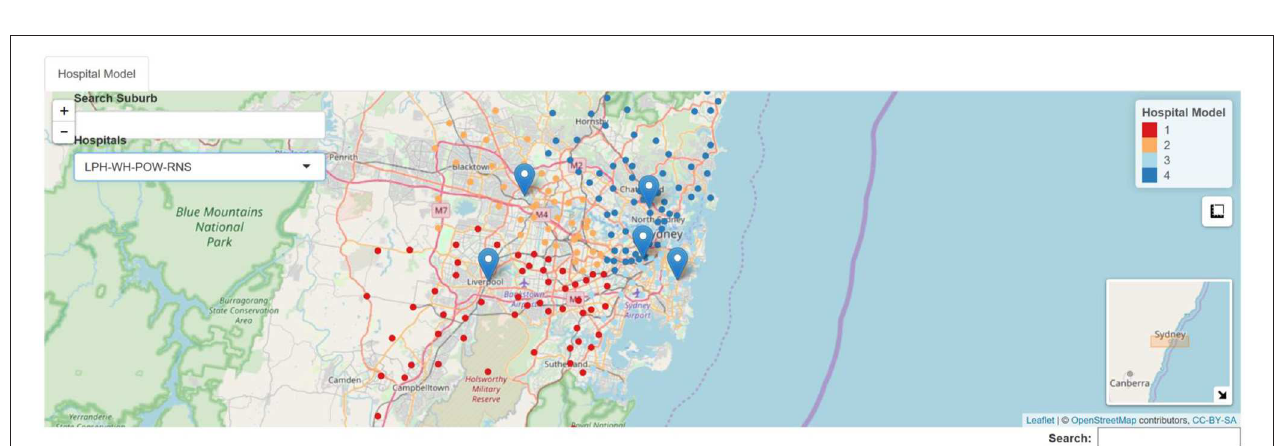
FIGURE 2 | Example of 4 hospital model. RNS, Royal North Shore Hospital, blue; LPH, Liverpool Hospital, red; WH, Westmead Hospital, orange, POW, Prince of Wales Hospital, light blue.